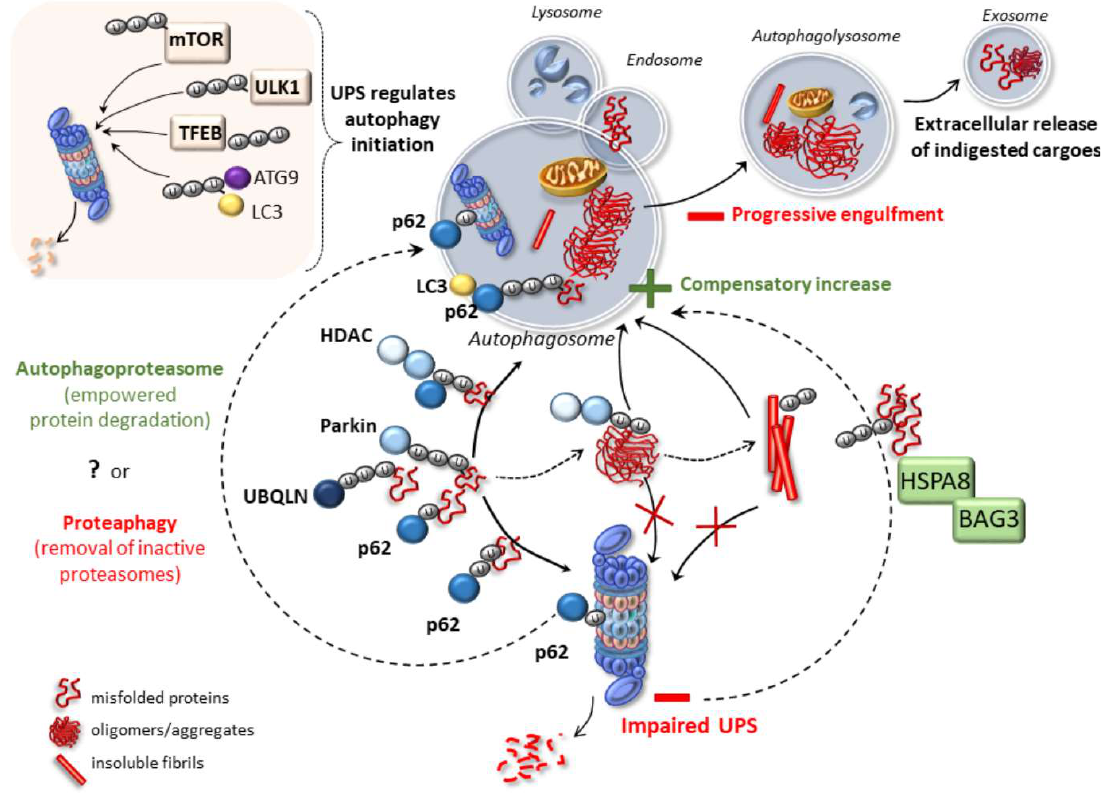
Figure 1. Crosstalk mechanisms between ubiquitin proteasome system (UPS) and autophagy. Ubiquitin tagging is key in sorting misfolded proteins for either UPS- or autophagy-dependent degradation. Several proteins, including UBQLNs, Parkin and SQSTM1 / p62, link ubiquitinated misfolded / aggreagted proteins to either UPS or autophagy. Besides misfolded substrates, p62 is key in shuttling the same proteasome to autophagy vacuoles. Functionally, the merging of UPS with autophagy vacuoles may underlieeithertheformationofacell-clearingorganelleendowedwithempoweredclearingcapacity(the autophagoproteasome), or to the degradation of inactive UPS subunits (proteaphagy).